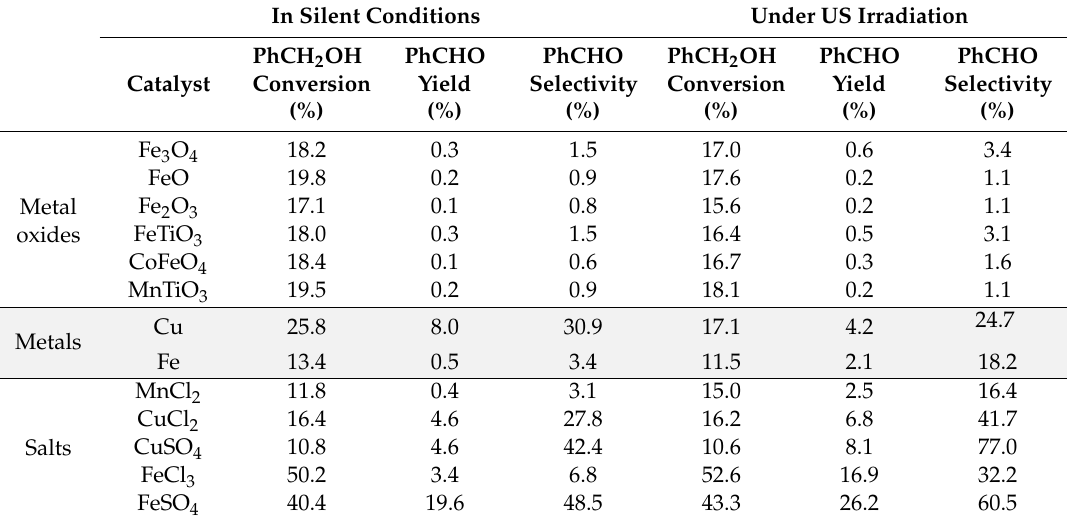
Table 2. Oxidation of PhCH 2 OH according to nature of catalyst: Mineral metal oxides and ionic crystals in silent condition and under US irradiation (20 kHz). Reaction conditions: 571 mM PhCH 2 OH, 1 molar eq. H 2 O 2 ; 1% molar eq. catalyst, 5.61 mL H 2 O, 70 ◦ C, 15 min. Silent conditions: Argon